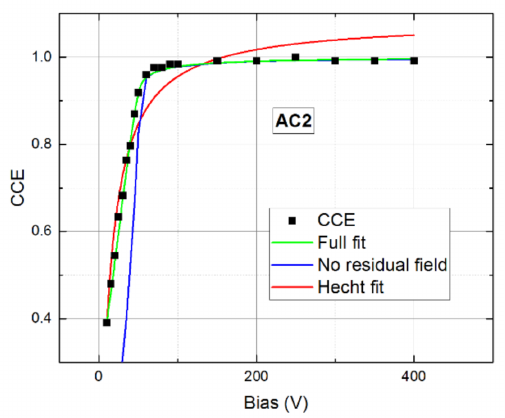
Figure 14. Bias dependence of the charge collection efficiency (CCE) on sample AC2. Full fit is plotted by the green line. The fit with the neglected residual field is blue. The fit with the obvious Hecht equation is